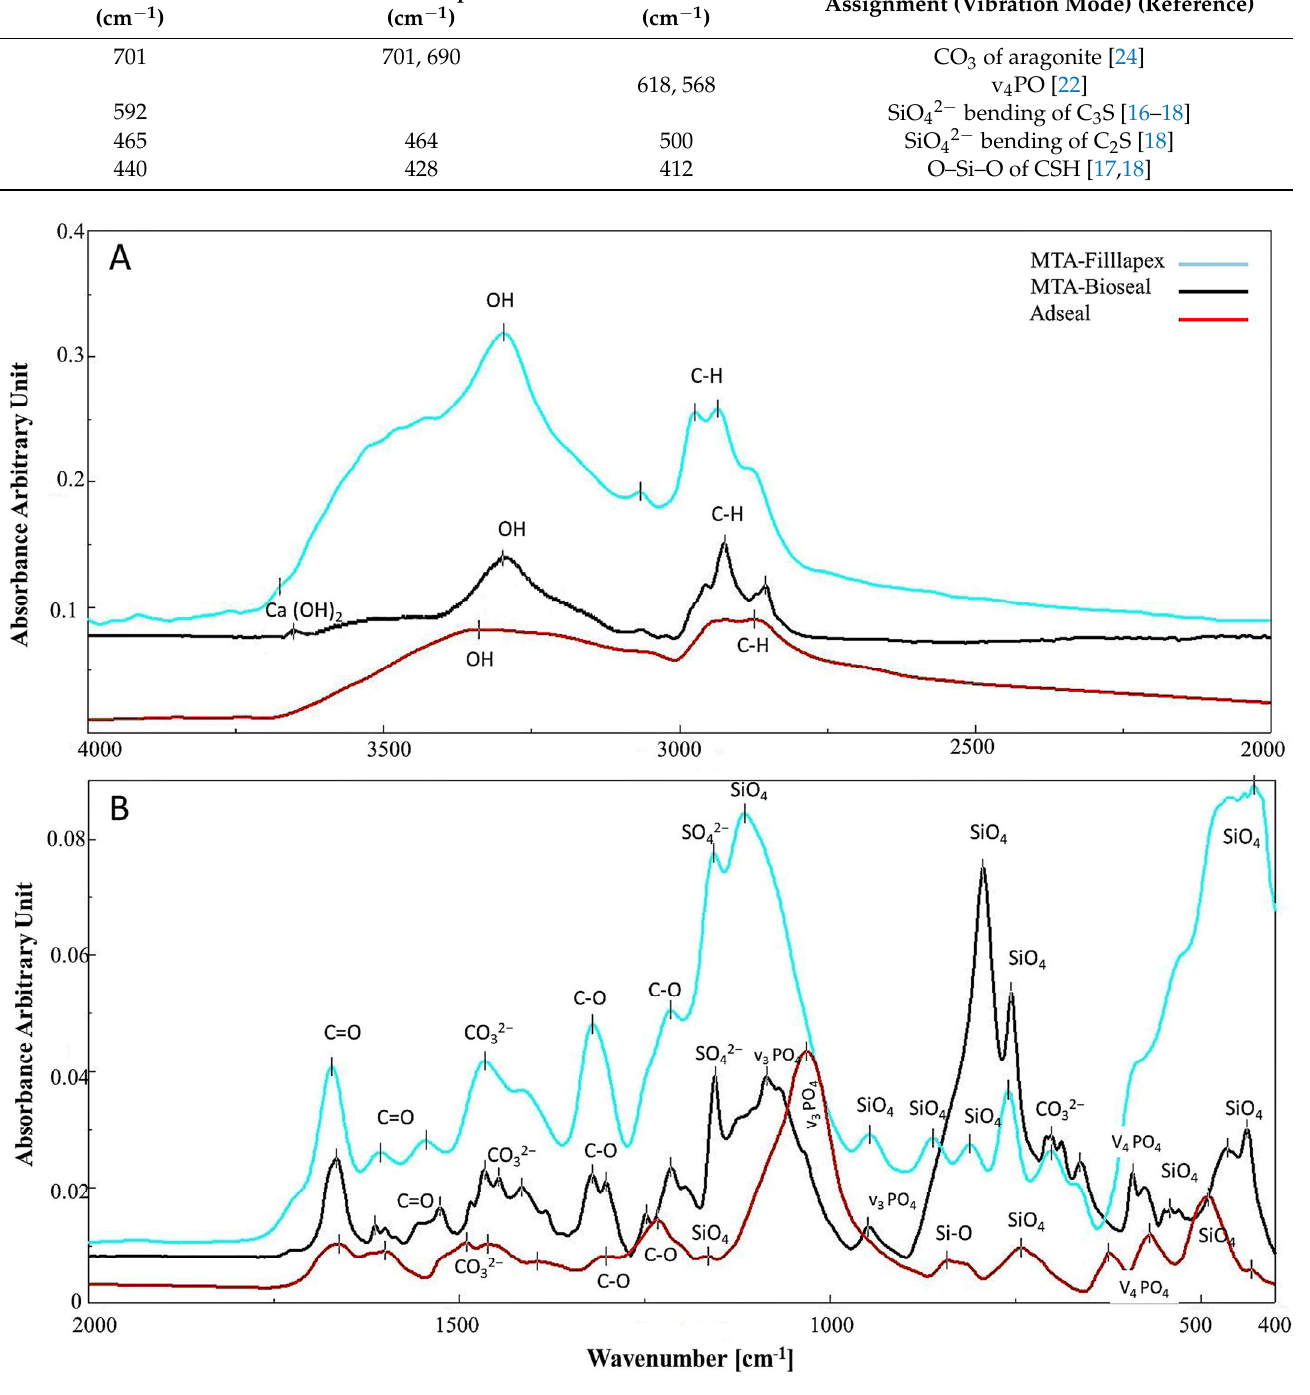
Figure 1. FTIR spectra of hydrated root canal sealers showing the composition of each sealer. At region 4000–2000 cm − 1 ( A ), the spectra detected bands of calcium hydroxide (Ca(OH) 2 ) , hydroxyl ion of absorbent water (OH), methyl (C–H). At region 2000-400 cm − 1 ( B ), the spectra detected amide I (C=O) of salicylate resin, carbonate (CO 3 2 − ), sulfate (SO 4 2 − ), phosphate (PO 4 ), and silicate group (SiO 4 ) of calcium silicate. Table 1. Fourier transform infrared spectroscopy (FTIR) information of analyzed root canal sealers.